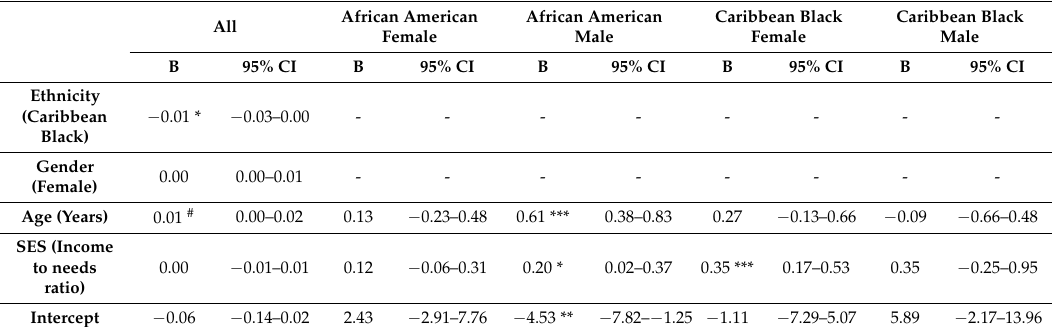
Table 3. Summary of linear regression on the effects of income to needs ratio on perceived discrimination.